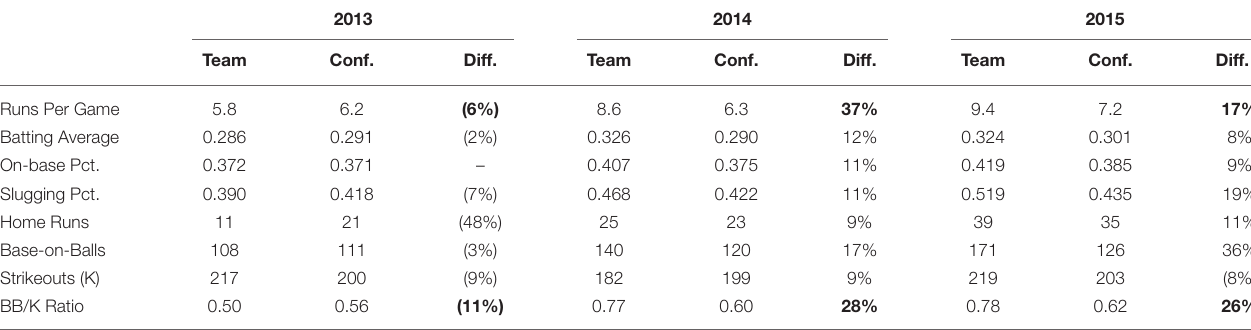
TABLE 1 | Differences in Batting Statistics: Cooperating Team vs.